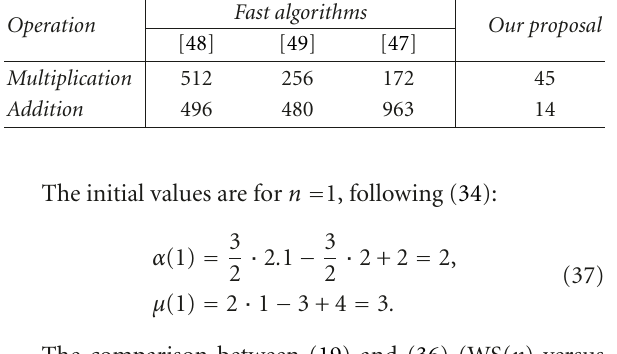
Figure 3 represents the growing rates s ( n ) = α ( n ) / SS( n ) and m ( n ) = μ ( n ) / WS( n ) versus n